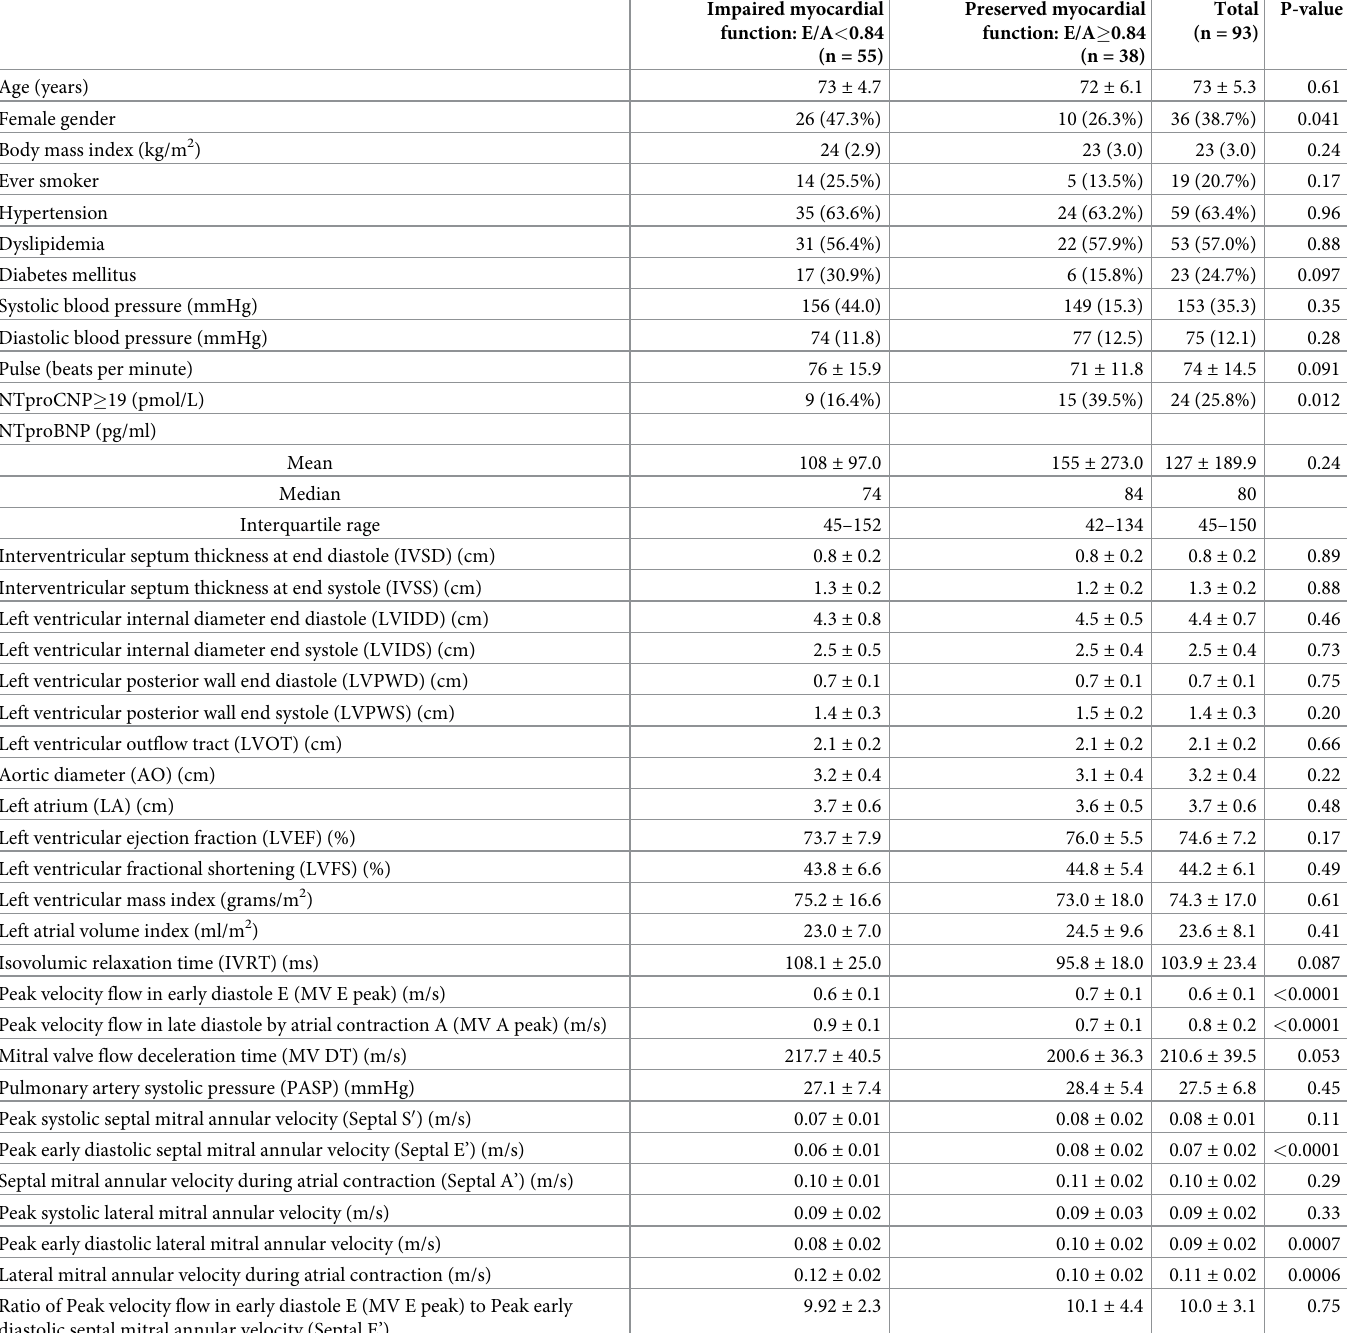
Table 1. Baseline characteristics of study